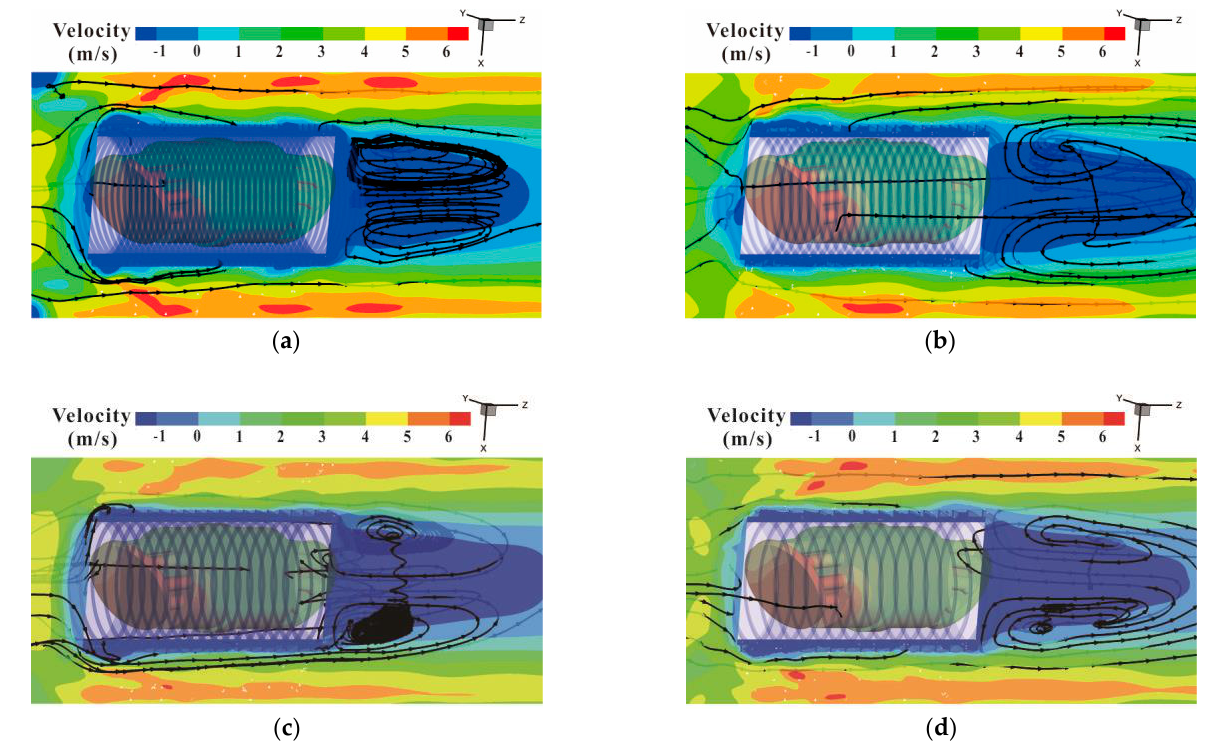
Figure 11. Velocity distribution with a fin height h = 10 mm and fin thickness t = 2 mm when ( a ) fin pitch p = 10 mm; ( b ) fin pitch p = 15 mm; ( c ) fin pitch p = 20 mm; ( d ) fin pitch p = 25 mm.